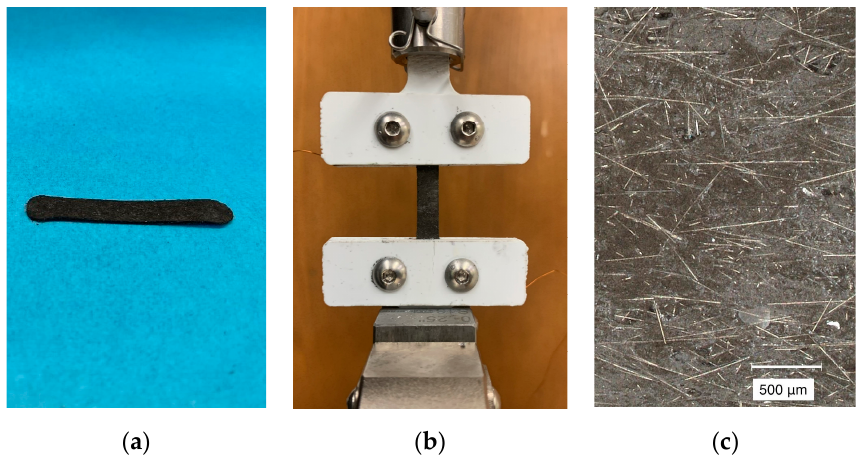
Figure 1. Depiction of ( a ) the high-deflection strain gauges; ( b ) the strain gauge during a tensile test; and ( c ) a microscopic image of the sensors under a small load. During tensile tests ( b ), the sensor was secured between two polypropylene grips. The grips contained a copper metal interior coating to facilitate measurement of the strain gauge’s electrical resistance at different loads.